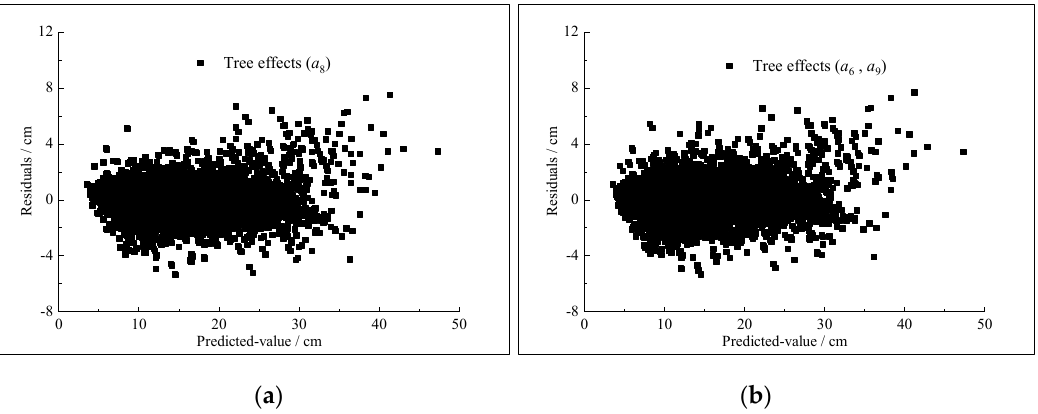
Figure 6. Mixed model residuals. ( a ) Introduce a residual distribution diagram of a random parameter ( a 8 ); ( b ) consider the residual distribution diagram with two random parameter combi-nations ( a 6 and a 9 ). Table 9. Comparisons of mixed models with an autocorrelation matrix for larch plantation.